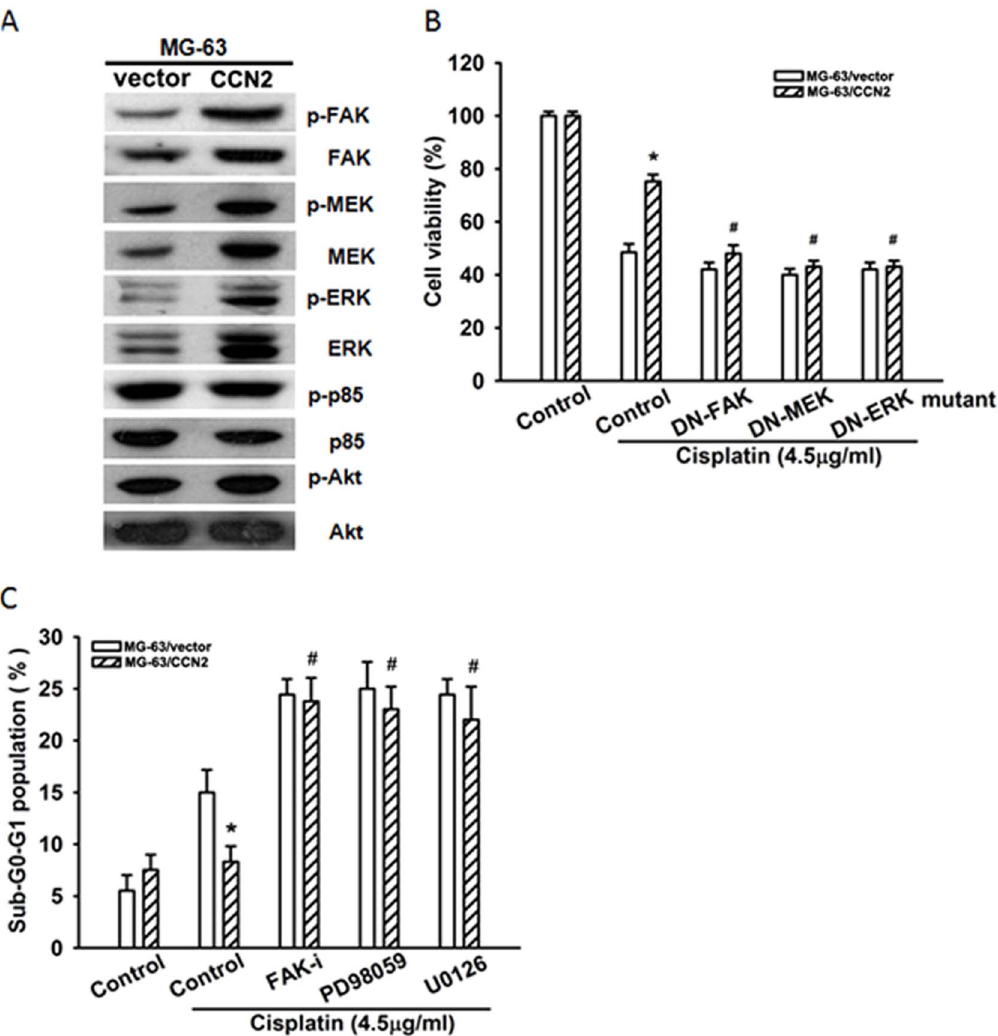
Figure 5. CCN2 activates FAK, MEK, and ERK survival signaling pathways during chemoresistance. (A) Protein expression was examined by western blotting. (B & C) Cells were transfected with FAK, MEK, and ERK mutants or pretreated with FAK inhibitor (10 m M), PD98059 (10 mM), and U0126 (10 m M), followed by stimulation with cisplatin for 24 h. Cell survival ability and apoptosis were examined by MTT assay and PI staining. Each experiment was done in triplicate. Results are expressed as mean 6 SEM. *, p , 0.05 as compared with MG-63/vector group; # P , 0.05 compared with MG-63/CCN2 cisplatin-treated control group.